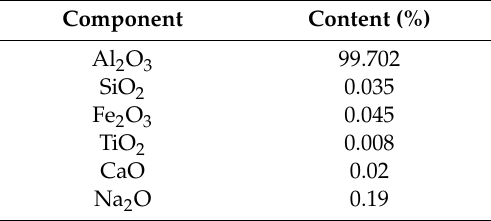
Table 4. Chemical composition of white corundum used for the sandblasting of Ti